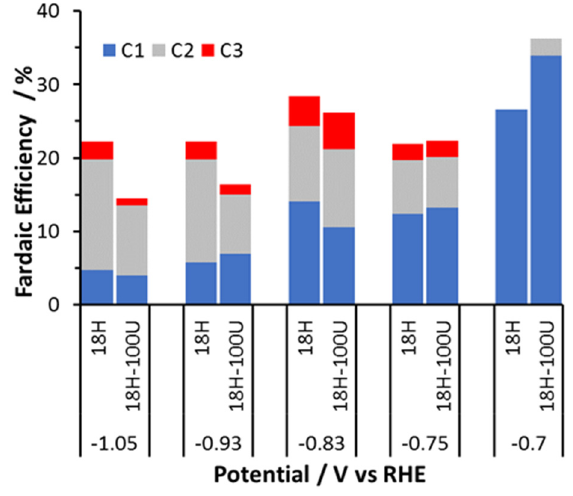
Figure 8. Bar chart depicting the product distribution from CO 2 reduction at different electrocatalytic reduction potentials comparing CF-18H and CF-18H-100U.